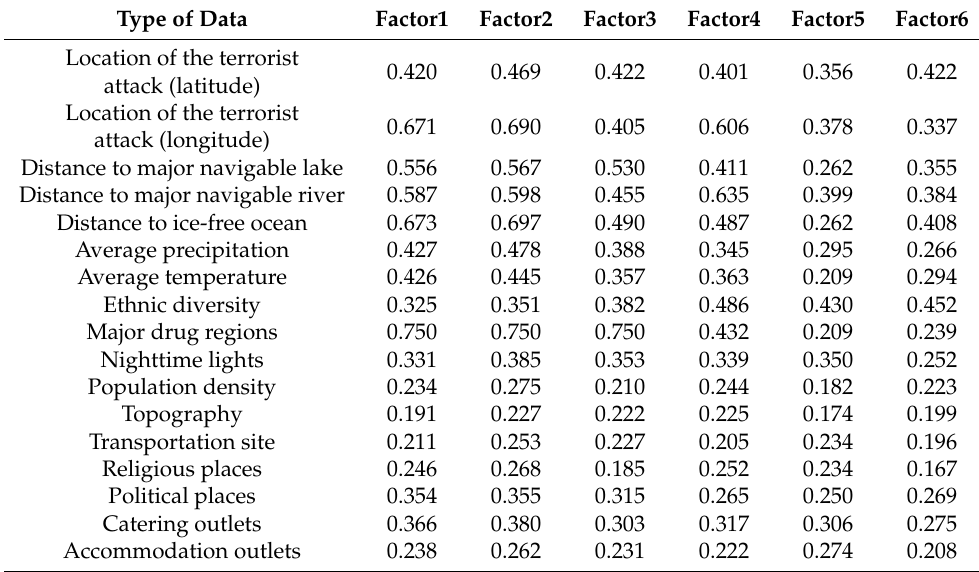
Table 2. Factor correlation before and after dimensionality